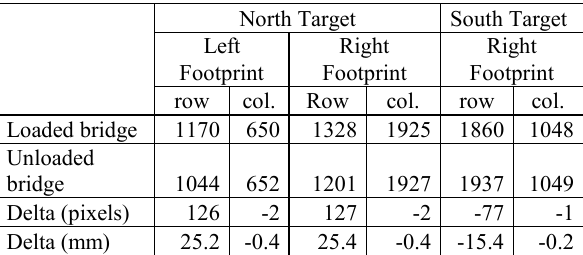
Table 3. Coordinates of the centroids of footprints. The values are in pixels except for the bottom row. We observe a rise in the footprint on the northern target of 127 pixels, equal to 25.4 mm. On the south target, there is a lowering of 77 pixels, equal to -15.4